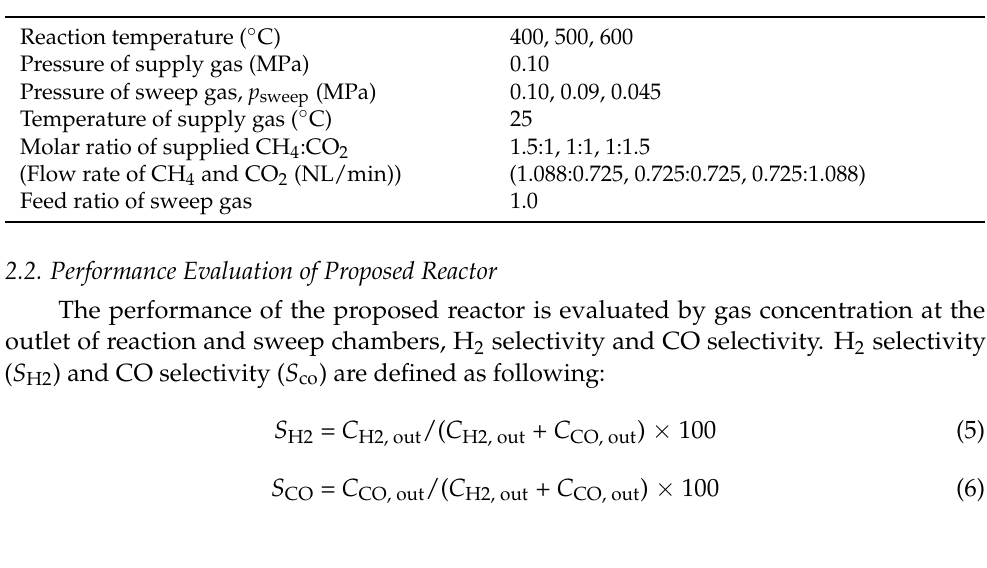
Table 1. Experimental